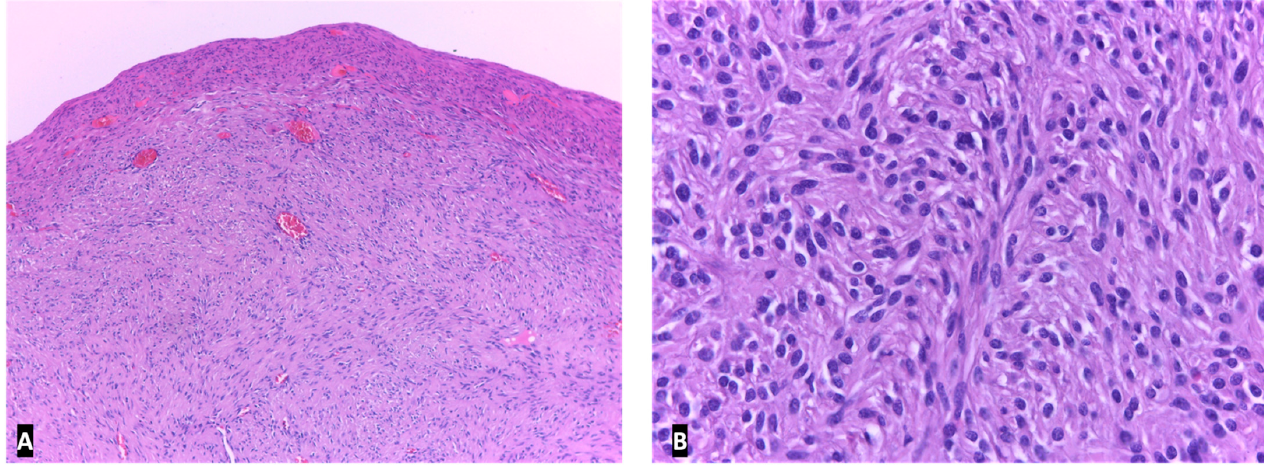
Figure 10. Lymph node metastasis of NEN, in Hematoxylin and eosin stain, ×40.